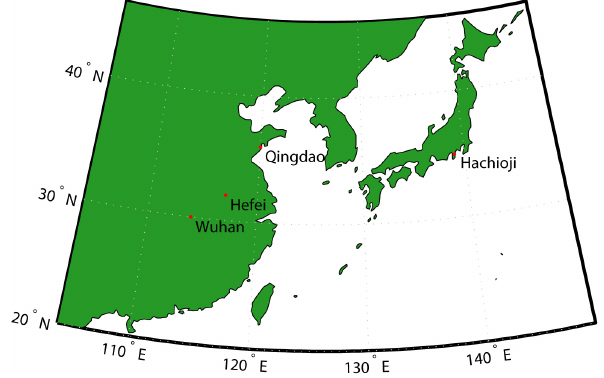
Figure 1. A map showing the relative positions of four lidar sites.